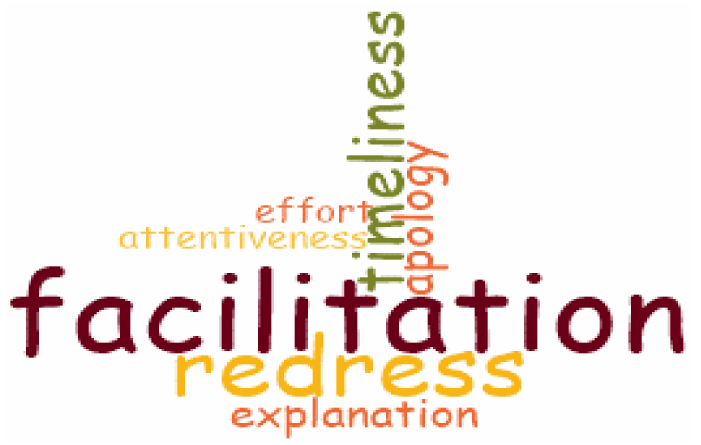
Figure 5. Word cloud for FM response